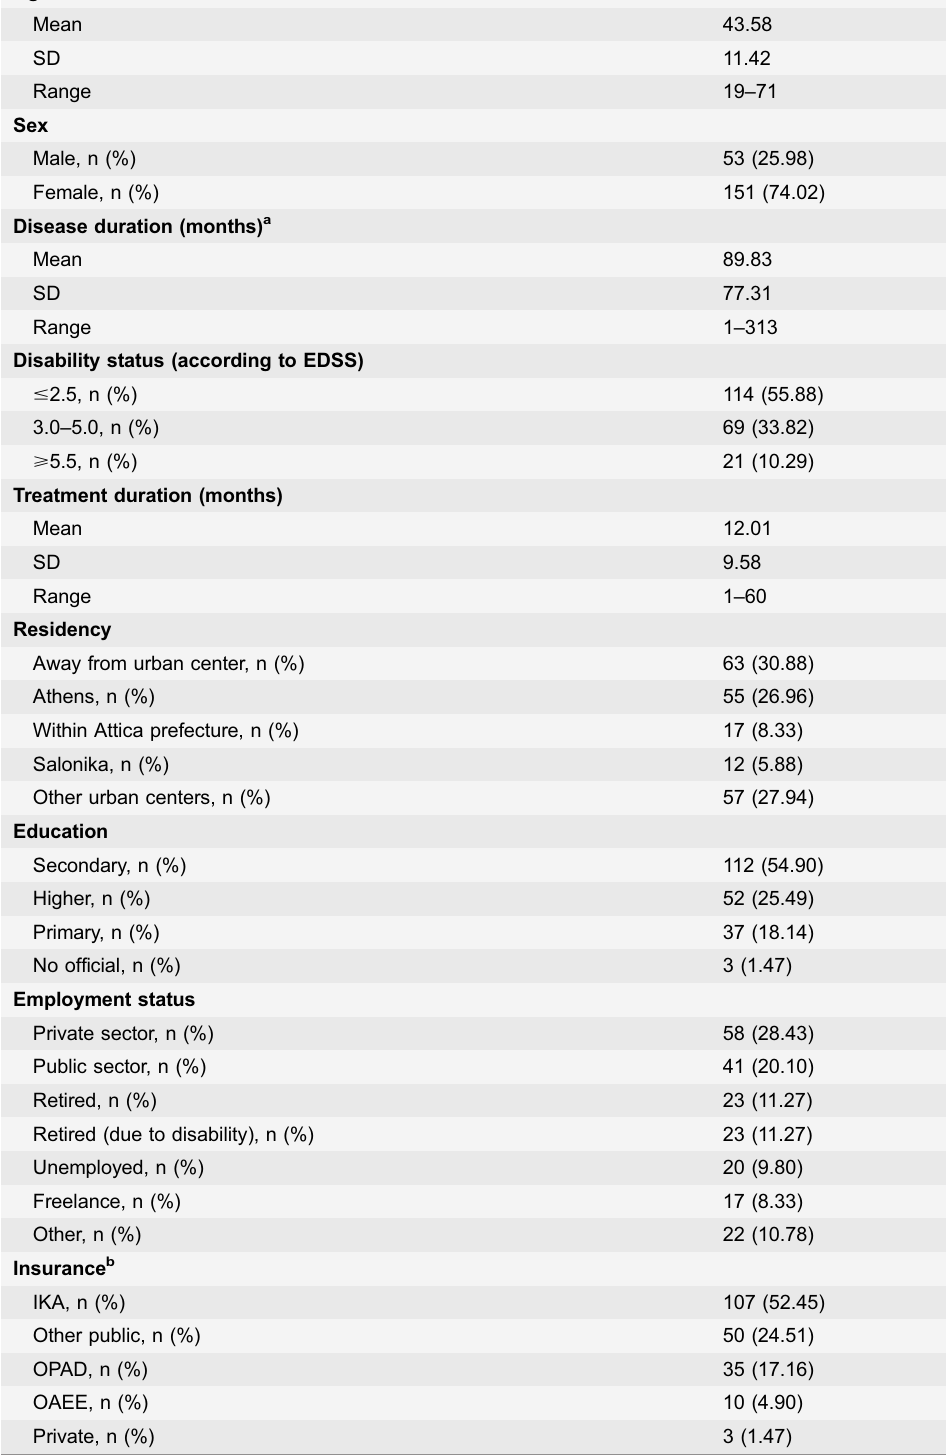
Table 1. Demographic and clinical attendance characteristics of the studied population (n 5